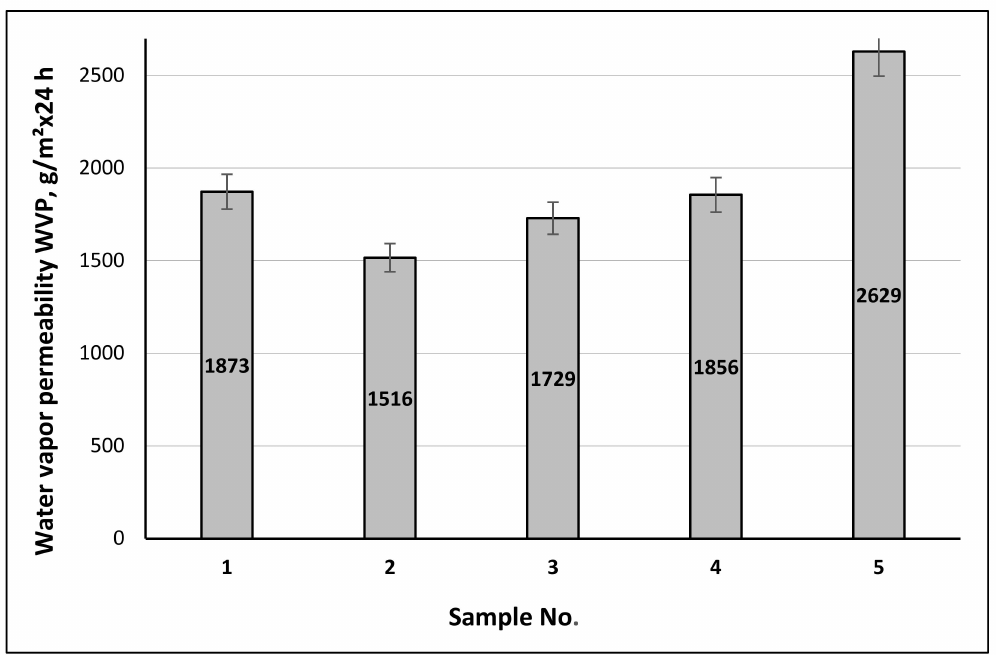
Figure 15. Water vapor permeability of various structures of the socks.